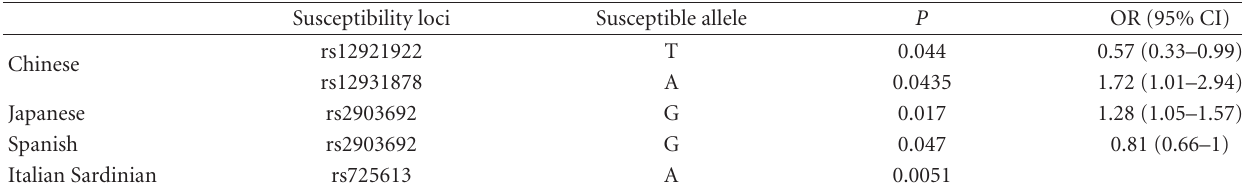
Table 4: Loci in the CLEC16A gene related to susceptibility of T1DM in di ff erent ethnic